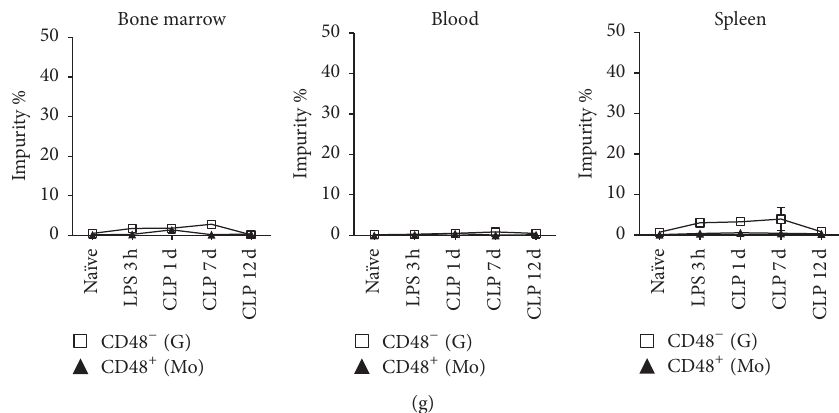
Figure 3: Granulocytic and monocytic MDSC subsets identified by CD48 expression. (a) Bone marrow, spleen, and blood cells were collected from na¨ıve and 7-day CLP Gfi1:GFP knock-in mice. MDSCs were gated as CD11b + Gr-1 + and sorted by CD48 expression. G-MDSCs were identified as CD11b + Gr-1 + CD48 − and M-MDSCs were identified as CD11b + Gr-1 + CD48 + cells. (b) Representative photomicrographs (images of bone marrow are shown) of Wright–Giemsa stained MDSC subsets, Bar = 10 𝜇 m. (c) Purity analysis of each MDSC subset by cell morphology. (d) Gfi1:GFP expression in CD11b + Gr-1 + CD48 − and CD11b + Gr-1 + CD48 + cells. Representative flow cytometry data are shown. (e) Purity analysis of MDSC subsets by Gfi1 expression. (f) Gfi1:GFP knock-in mice were treated with LPS (i.p. 10mg/kg) or by CLP